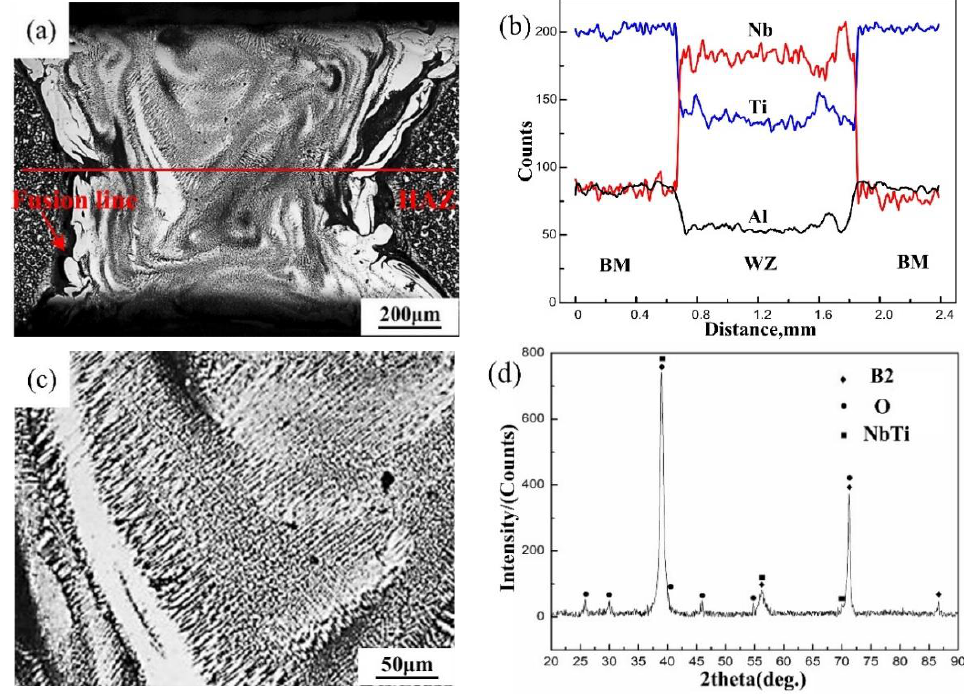
Figure 7. The weld morphology ( a ), EDS result ( b ), weld microstructure ( c ) and XRD result ( d ) of a laser-welded joint produced with pure Nb filler metal. Table 4. The composition of the white region and gray region in the weld with Nb filler metal. Elements